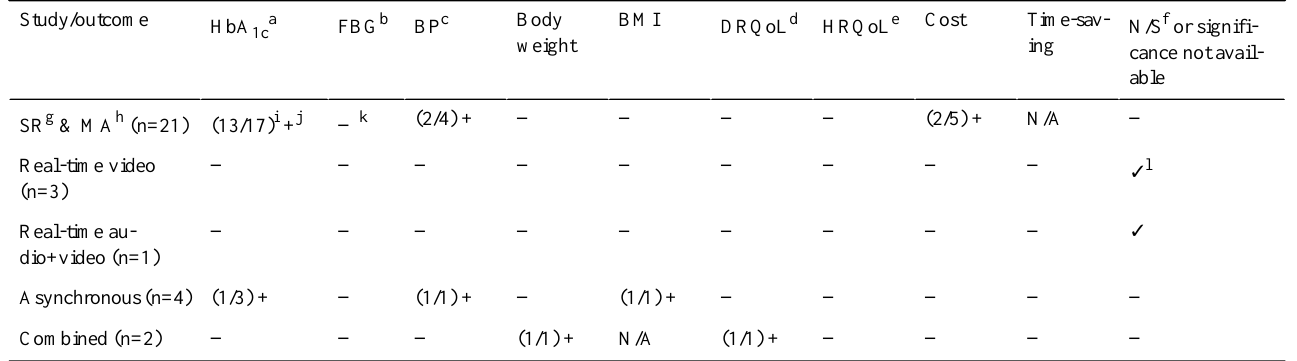
Table 3. Significant effects on primary outcome HbA 1c and secondary outcomes (intra- and intergroup).